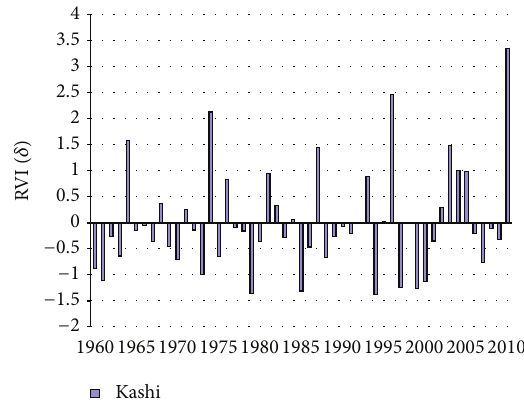
Figure 3: Annual rainfall variability indices for the 9 synoptic stations.